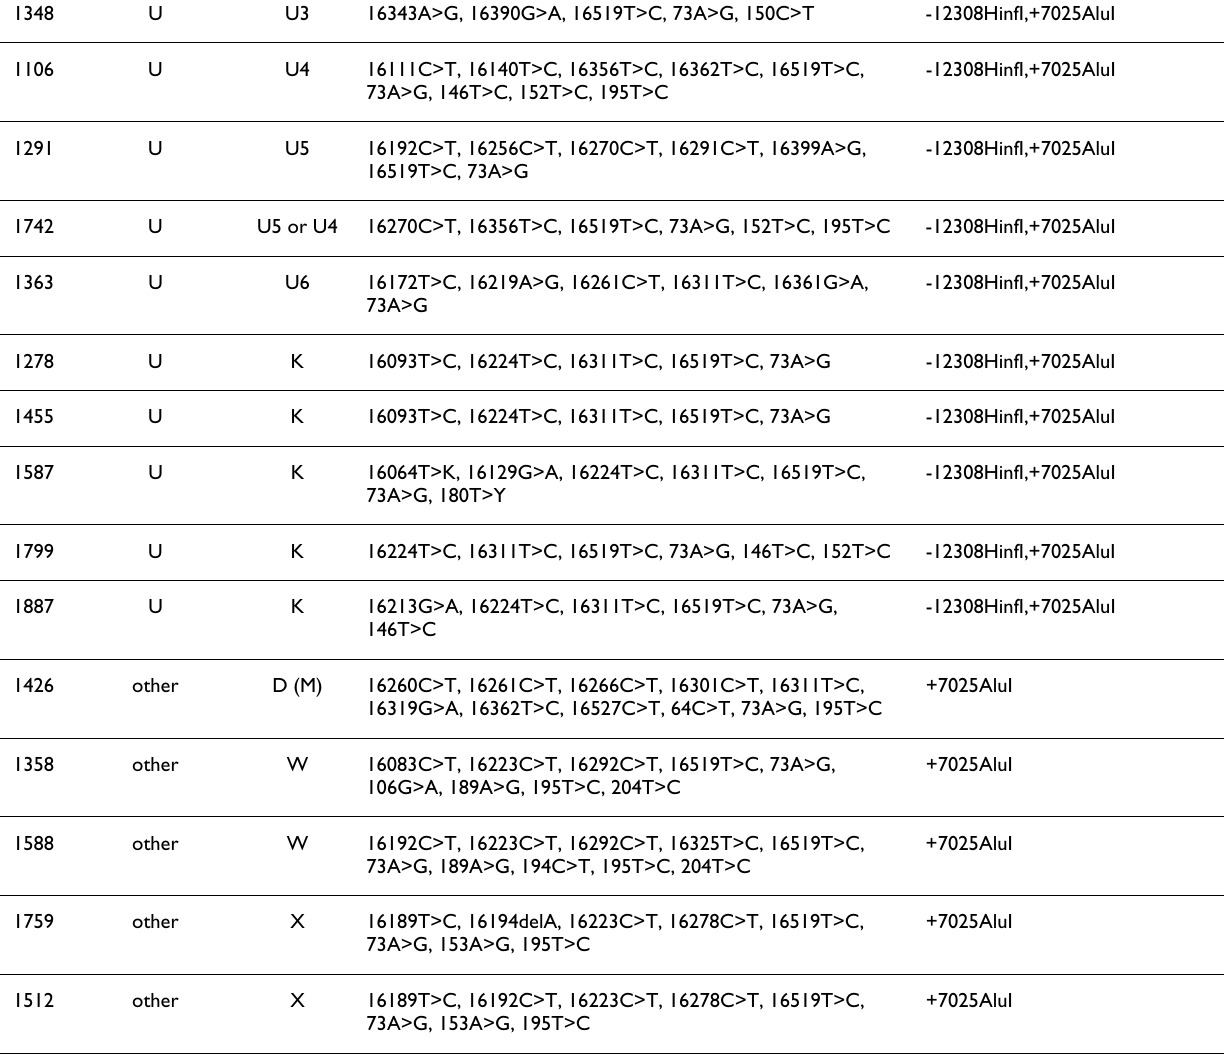
Table 1: RFLP and Control-Region mtDNA Haplotypes from the French OPA1 mutation carrier